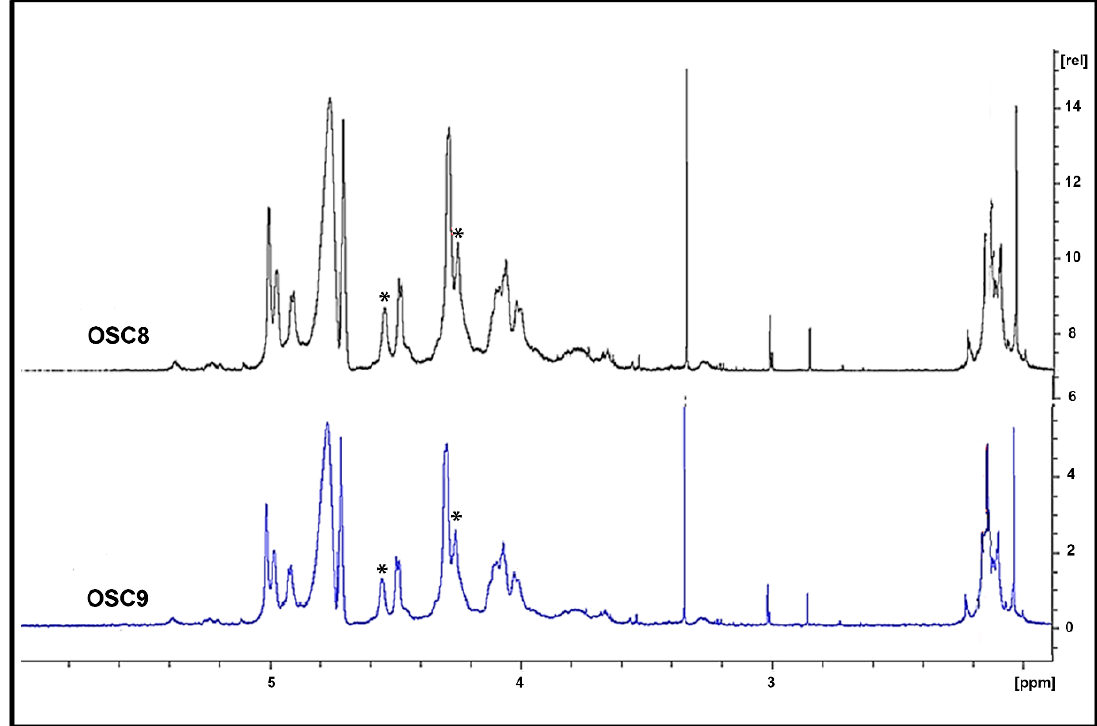
Figure 6. 1 H-NMR spectra of sulfated contaminants isolated from crude heparins OSC8 and OSC9 show distinct structure. The isolated contaminants purified were structurally characterized by nuclear magnetic resonance ( 1 H NMR). Solutions of 20 mg / mL of each sample in deuterium oxide (99.9%) were analyzed for the acquisition of free induction decay (FID) using 16 scans, 90 ◦ pulse and 20 s delay at 37 ◦ C in a Bruker Spectrometer DRX-500. Sulfated contaminants purified from crude batches (OSC8 and OSC9) in the 1 H NMR spectra show signals in the 4.55 ppm region, marked with asterisks (*), that may correspond to non-fully substituted glucuronic acid residues and are not detected in OSCS.